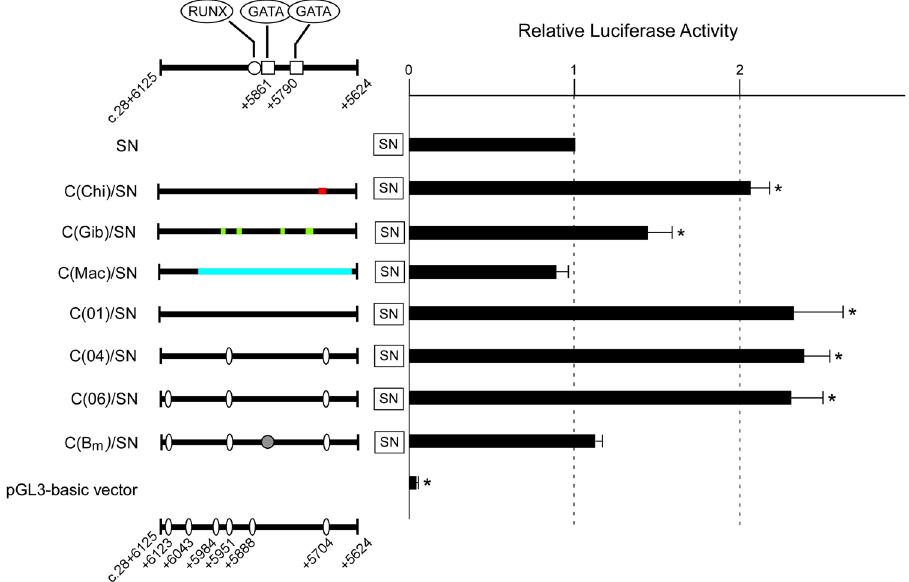
Figure 3. Transcriptional regulatory activity of the human + 5.8-kb site was lost by change from its homologs in apes to the corresponding site in Japanese macaque. K562 cells were transiently transfected with ABO enhancer- luciferase gene constructs including SN, C(01)/SN, C(04)/SN, C(06)/SN, and C(B m )/SN as well as C(Chi)/ SN, C(Gib)/SN, and C(Mac)/SN. Reporter plasmid SN contained the human ABO promoter, and reporter plasmids C(01)/SN, C(04)/SN, and C(06) comprised the promoter and + 5.8-kb site of haplotypes ABOInt1 * 01 , ABOInt1 * 04 , and ABOInt1 * 06 , respectively. Haplotypes ABOInt1 * 01 , ABOInt1 * 04 , and ABOInt1 * 06 were linked to the O allele, A allele and B allele, respectively, with a few exceptions attributable to genetic recombination 49 . Locations of the single nucleotide polymorphisms are shown by ovals. Reporter plasmid C(B m )/SN included the promoter and + 5.8-kb site harboring a mutation of the GATA recognition site in the background of haplotype ABOInt1 * 01 25 . Location of the mutation is denoted by a solid circle. Reporter plasmids C(Chi)/SN, C(Gib)/SN, or C(Mac)/SN contained the promoter and the sites corresponding to the human + 5.8-kb site in chimpanzee, agile gibbon, or Japanese macaque, respectively. The parts in red, green and blue in chimpanzee, agile gibbon, and Japanese macaque, respectively, represent differences from the human sequences. The results are expressed as the average fold of the activity observed for the promoter. The standard deviations indicated are for three independent experiments. The significance of differences was determined by Student’s t test at a significance level of p < 0.05 (*) compared to the relative luciferase activity of